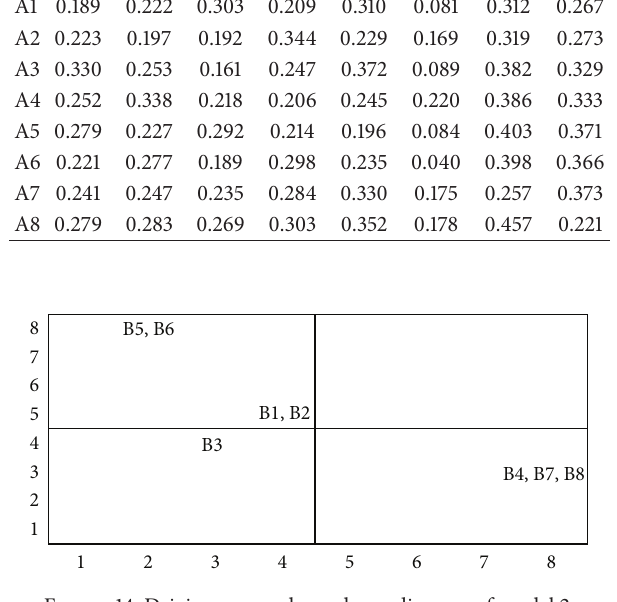
Figure 14: Driving power-dependence diagram of model 2.